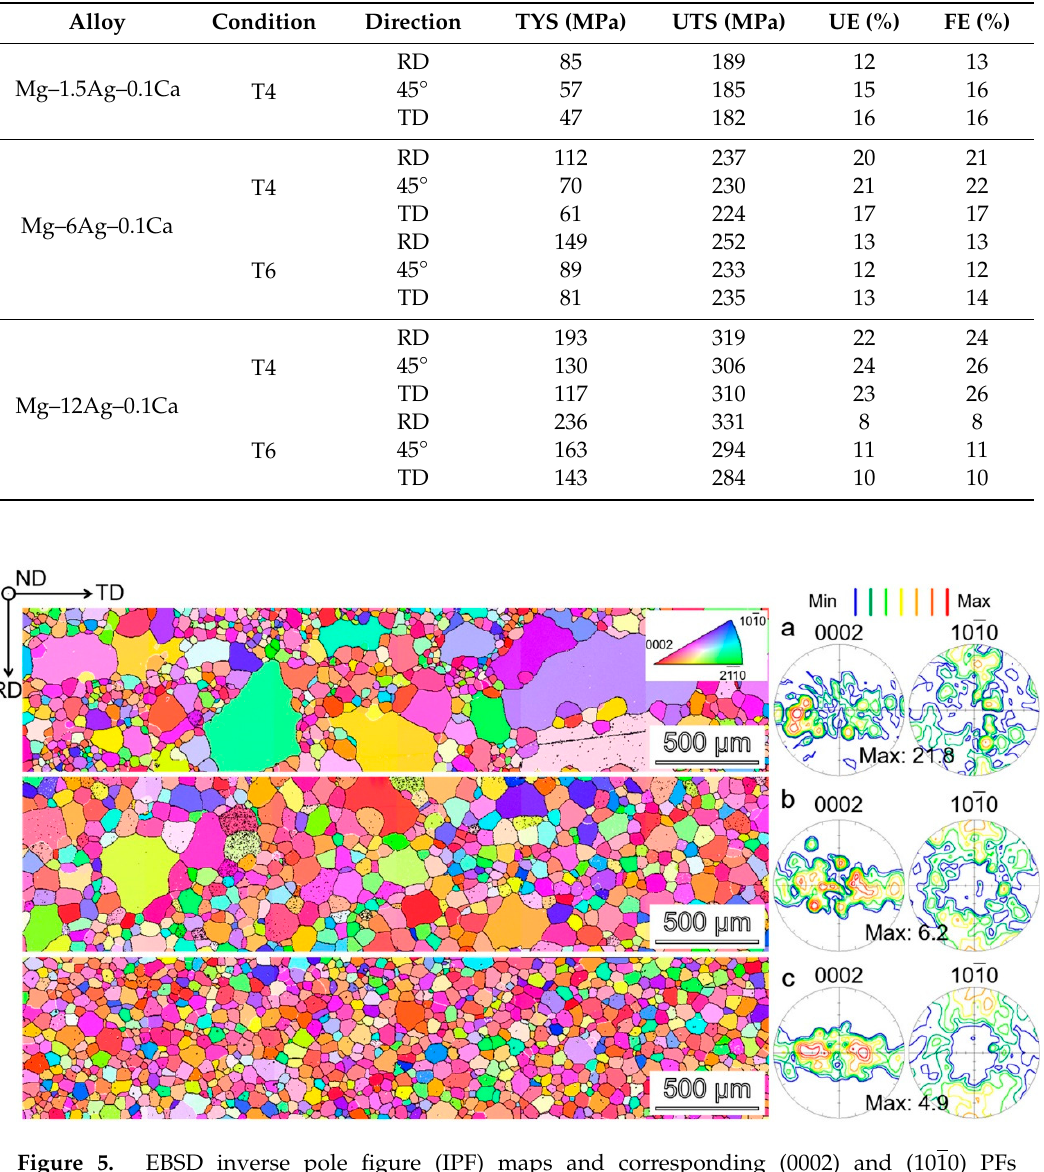
Table 3. RT tensile properties of 1.5Ag, 6Ag and 12Ag containing alloy sheets stretched along the RD, 45° and TD.